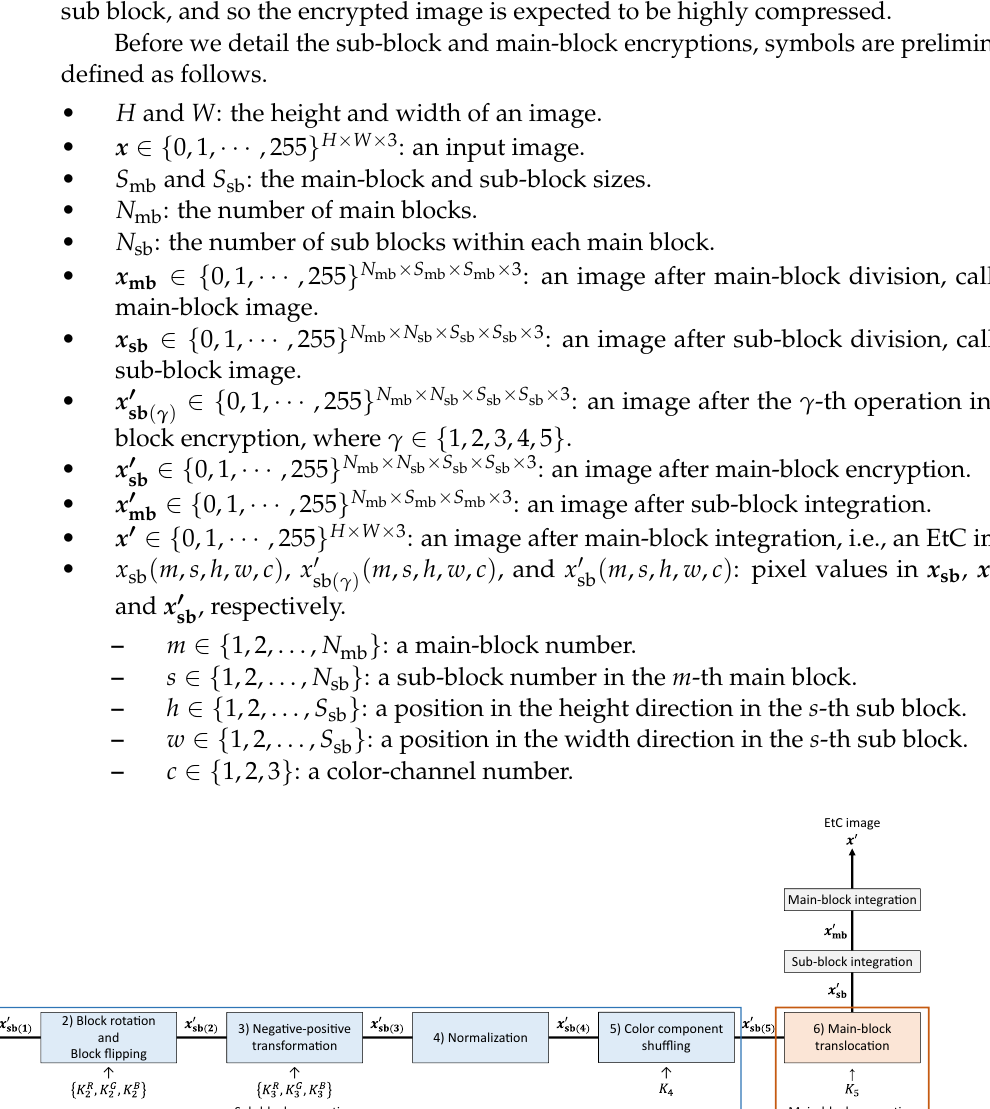
Figure 4. Image-encryption procedure.